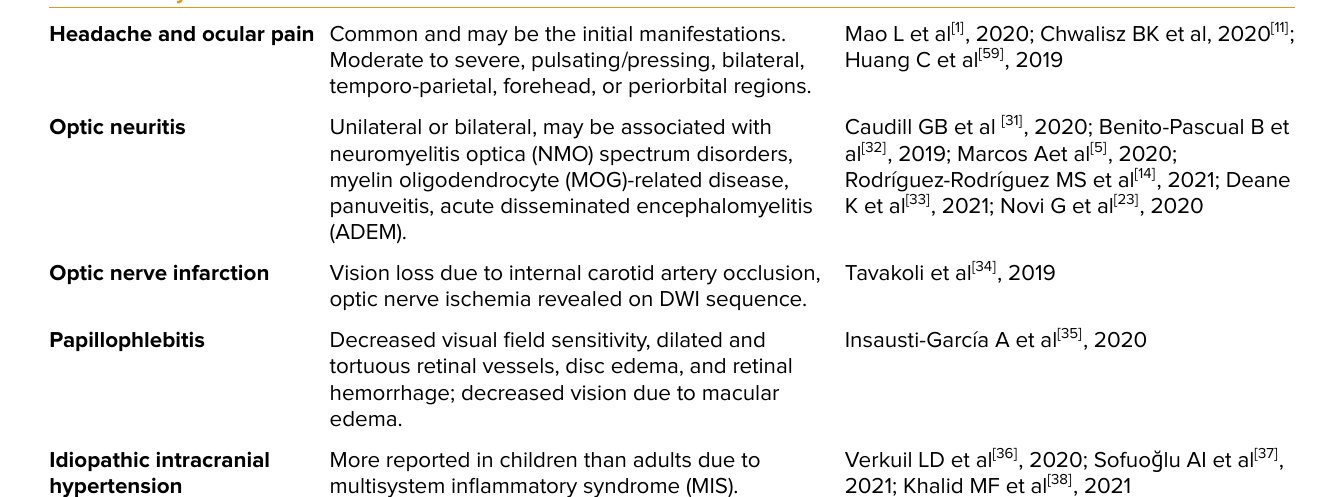
Table 1. A summary of reported neuro-ophthalmic manifestations of COVID-19. Clinical entity Clinical